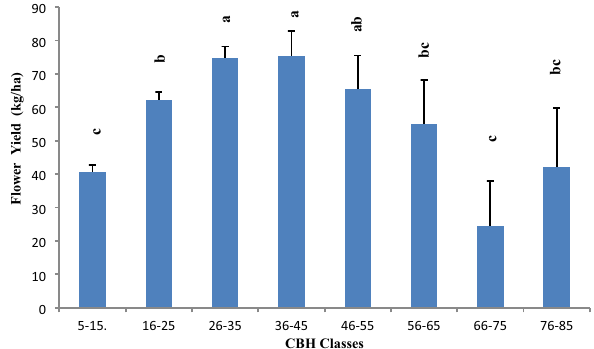
Figure 4. Mean flower yield (kg/ha) on R. arboreum trees across cbh classes in Garhwal region. Bar with different letters indicate significant difference (Kruskal–Wallis test; H = 76.75, df = 7, p <